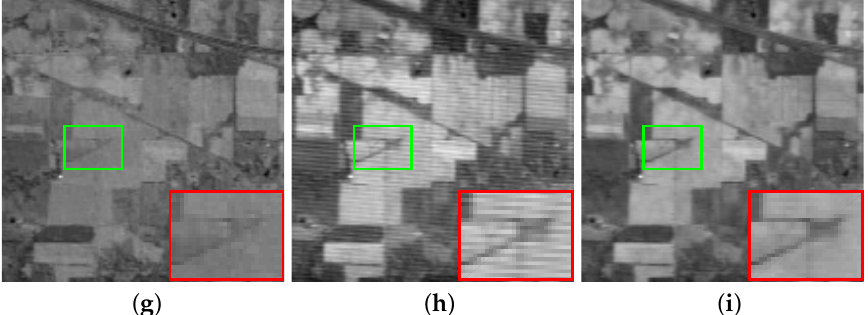
Figure 14. ( a ) Original image, image denoised by ( b ) LRTA, ( c ) BM4D, ( d ) LRMR, ( e ) LRTDTV,